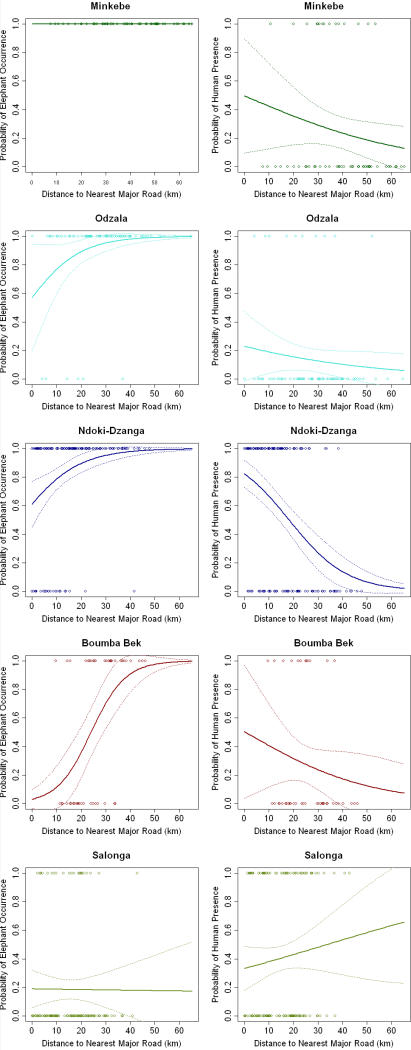
Results of Fitting a Logistic Regression Model to Elephant and Human Presence/Absence Data for Each MIKE Survey Site SeparatelyDistance to road (in kilometres) was used as the explanatory variable (except for probability of elephant occurrence for Minkébé where modelling is not required due to an effective probability of 1). Elephant data are shown to the left, and human data to the right. The observations and regression lines are colour-coded by site, and the 95% confidence interval is indicated by the dotted lines. The probability of elephant occurrence is significantly related to distance to road for all sites except Minkébé and Salonga. Due to the imprecision in the data and other influences not captured by distance to road, the probability of human presence is only significantly related to distance to road for the Ndoki-Dzanga site for the separate site analyses.